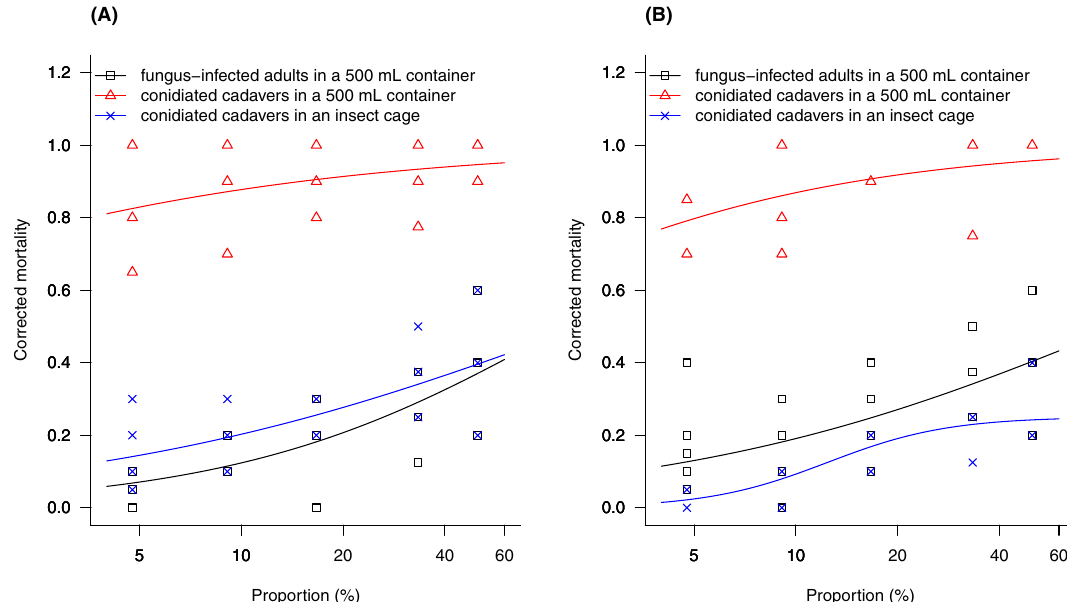
Figure 4. The non-linear relationship curves between the mortality of healthy adults at 9 days post- introduction and the proportion of ( A ) B27 or ( B ) ECS1 infected adults or conidiated cadavers in different experimental conditions. Individual symbol presents data of each replication and some were overlapped (bolded symbols) as shown in the figures. Models for ( A ): (∆) y =